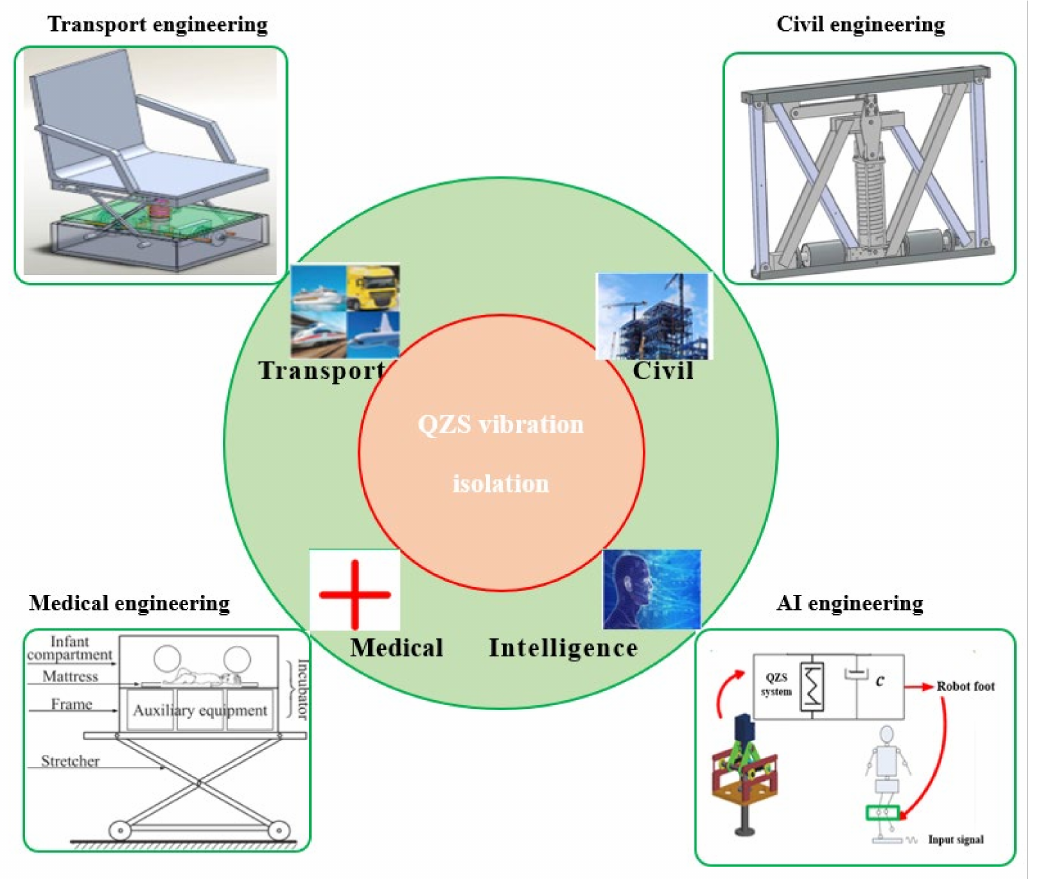
Figure 5. Engineering applications of QZS-based vibration isolation. Reprinted/adapted with permission from Ref. [56]. 2013 Elsevier Ltd. All rights reserved.Thanh Danh Le and Kyoung Kwan Ahn.Reprinted/adapted with permission from Ref. [57].Copyright The Author(s) 2017 Reprints and permissions. Jiaxi Zhou and Kai Wang. Reprinted/adapted with permission from Ref. [59].